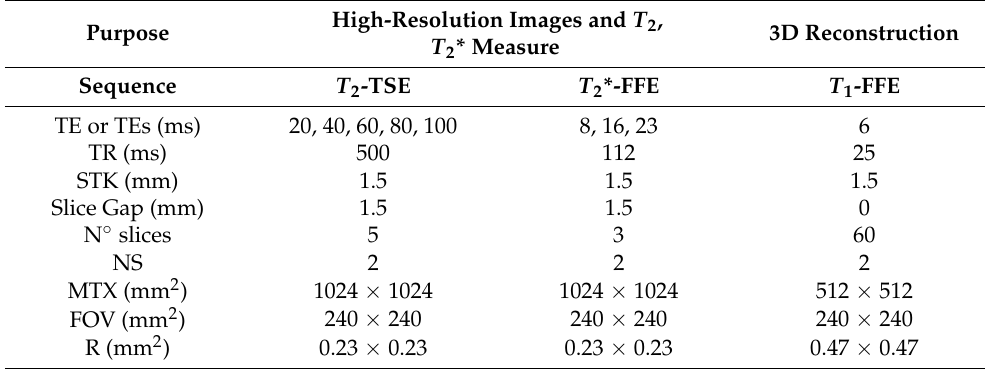
Table 3. Acquisition protocols used for the archaeological waterlogged wood